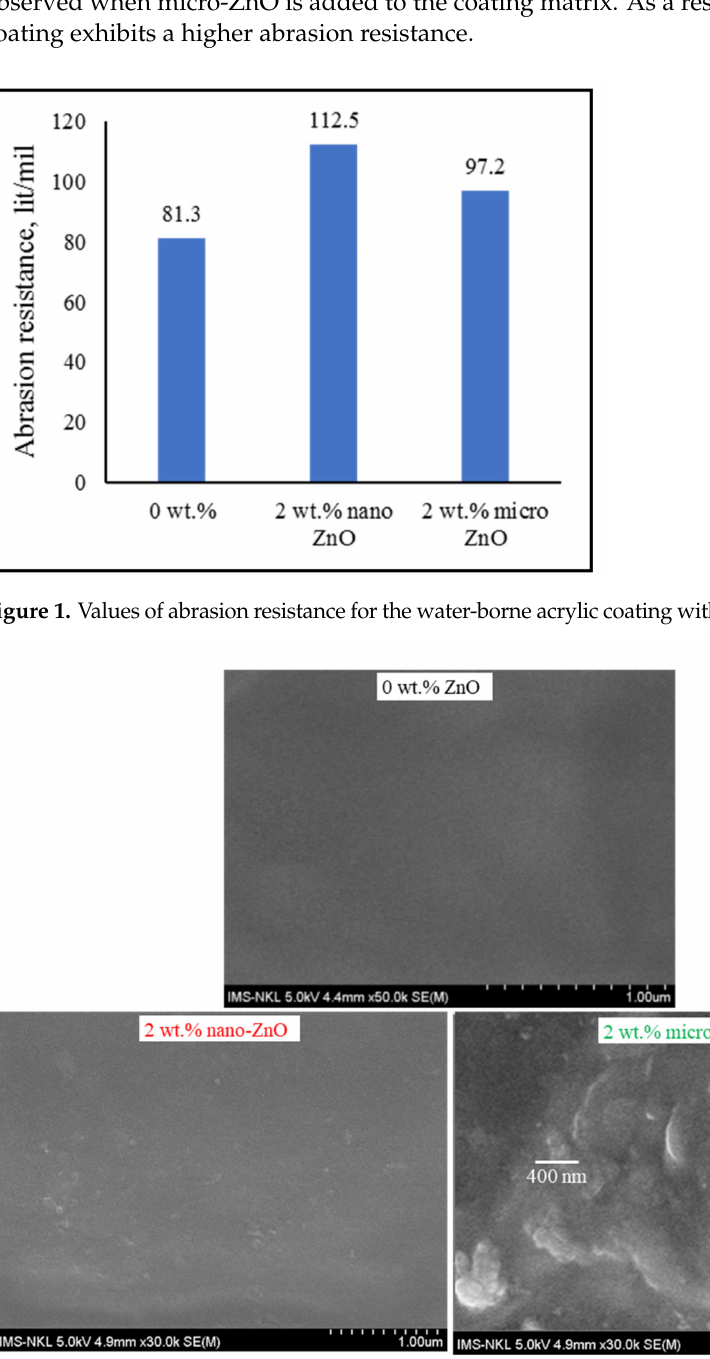
Figure 2. Morphology of acrylic coatings without (0 wt.% ZnO) and with ZnO particles (2 wt.% nano-ZnO and 2 wt.%